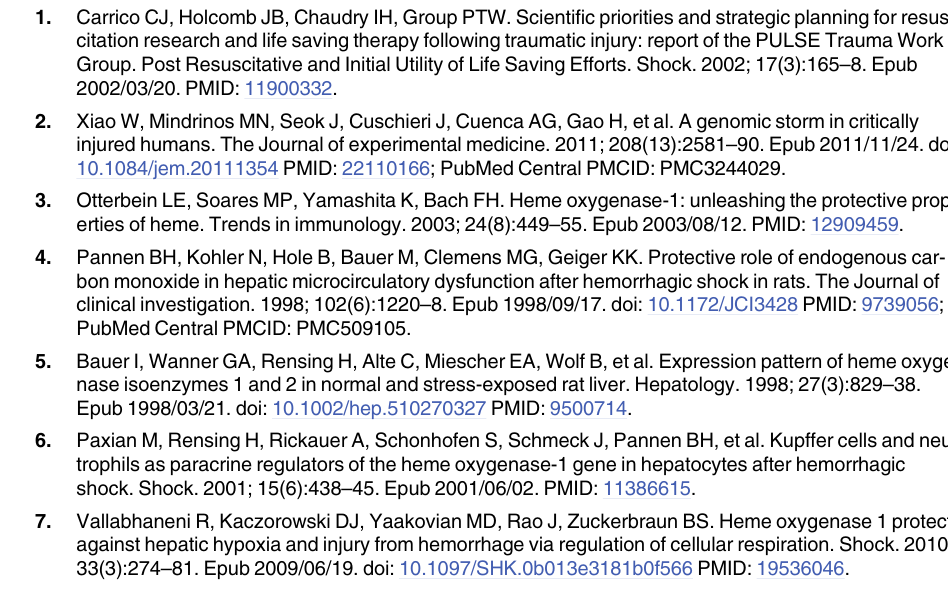
S1 Table. Total blood volume/hemorrhage volume from murine shock experiments. Murine shock models include “ Moderate, ” “ Severe Acute, ” and “ Severe Survival. ” In the “ mod- erate shock ’ model mice were hemorrhaged to a MAP of 25 mmHg and maintained at this MAP for 120 minutes. CO or control therapy was initiated 90 minutes into establishing a MAP of 25 mmHg. This model was used for measurements of organ injury (ALT, Myeloperoxidase activity, and lipid peroxidation), as well as systemic inflammation by serum cytokines. In “ severe acute ” mice were bled to a MAP of 20 mmHg and maintained at this pressure for 30 minutes or until mice could no longer compensate. No blood was returned in this model. In “ severe survival ” mice were hemorrhaged to a MAP of 20 mmHg and maintained at this pres- sure for 30 minutes. Mice were then resuscitated with shed blood to a MAP of 25 and main- tained at this pressure for an additional 60 minutes. CO or control therapy was initiated 30 minutes into re-establishing a MAP of 25 mmHg. See methods for further details. Estimated total blood volume was calculated assuming a murine blood volume of 78 microliters per gram. S2 Table. Total blood volume/hemorrhage volume from porcine shock experiments. Sham pigs underwent anesthesia and surgical manipulation without hemorrhage. Randomization of shocked pigs to control or CO therapy was carried out 55 minutes into the hypotensive period. CO therapy was started 60 minutes after the establishment of a MAP of 30